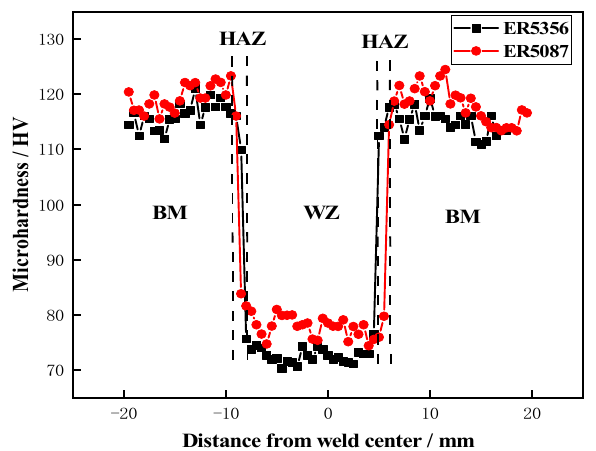
Figure 7. Microhardness distribution of the cover layer of two welded joints.